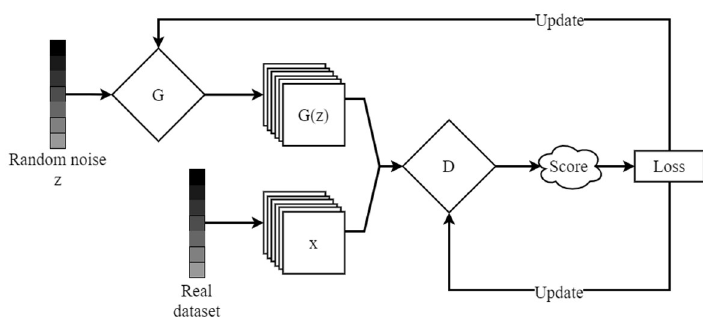
Figure 1. Framework of